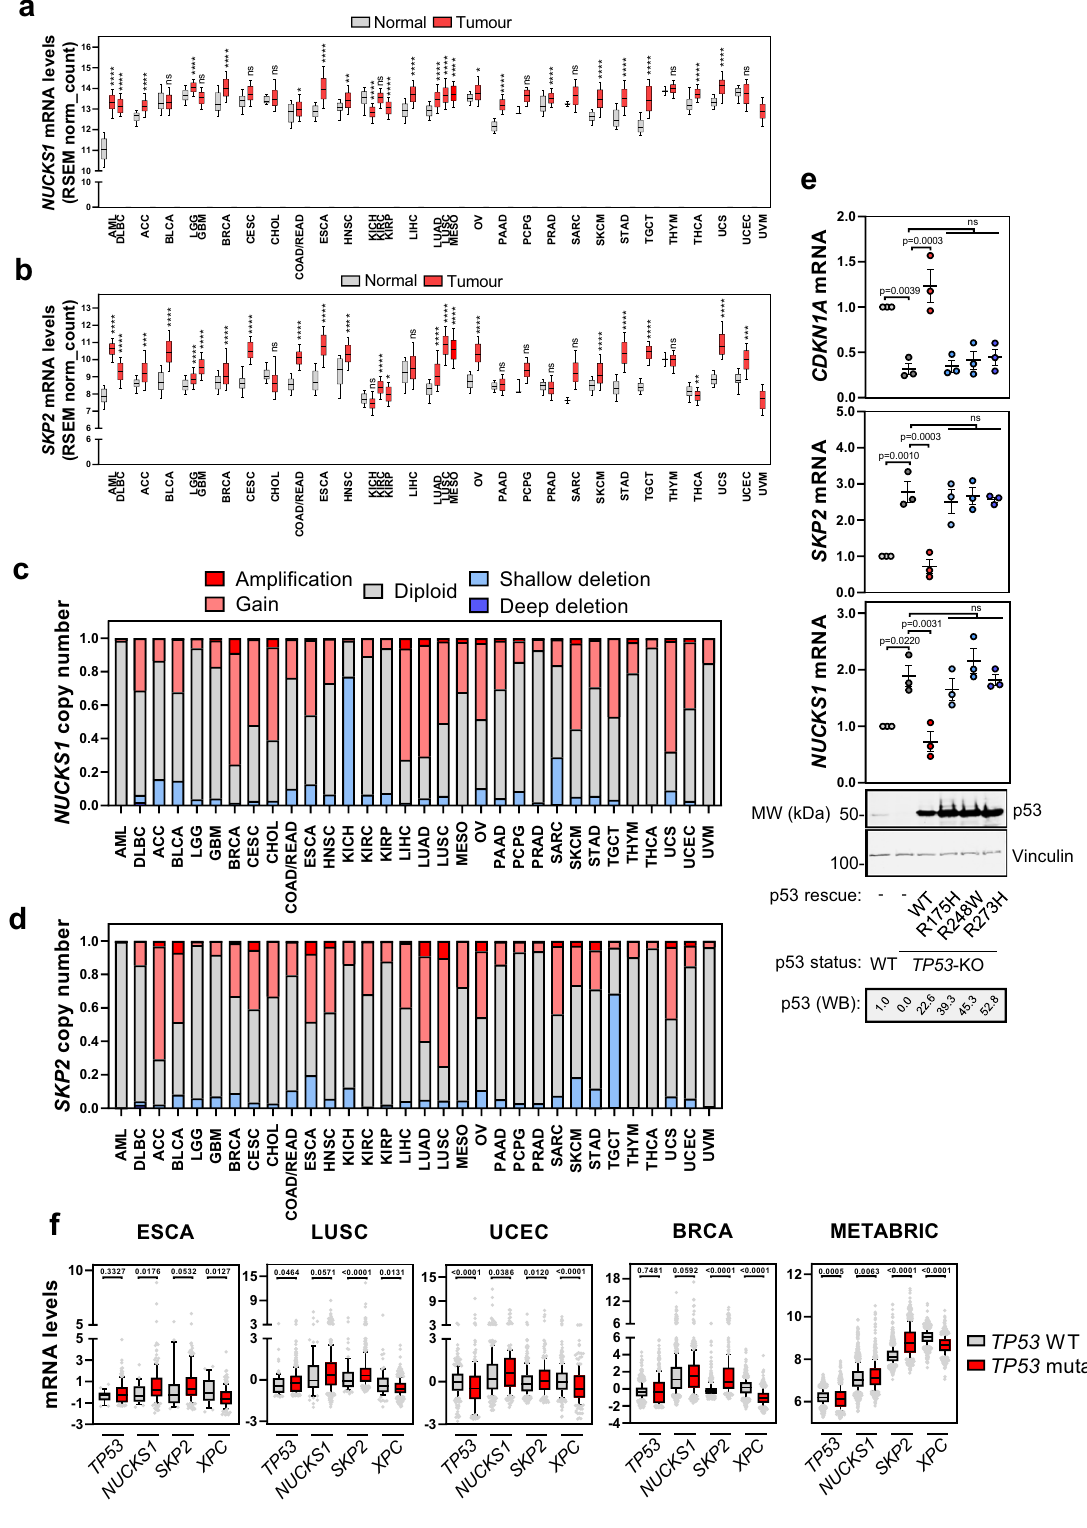
10 mM HEPES, 100 mM NaCl, 0.3M sucrose, and 3 mM MgCl 2 , and then fi xed in 4% formaldehyde for 15 min on ice. Cells were blocked overnight in 5% BSA at 4 °C, and primary antibodies (indicated in Supplementary Table 3) were diluted in 2.5% BSA and incubations performed for 1 h at RT. Cells were washed in PBS, incubated in secondary antibodies (indicated in Supplementary Table 3) for 1 h at RT, and stained with DAPI. Microscopy was performed using the Nikon NiE and quanti fi cation was performed using CellPro fi ler 76